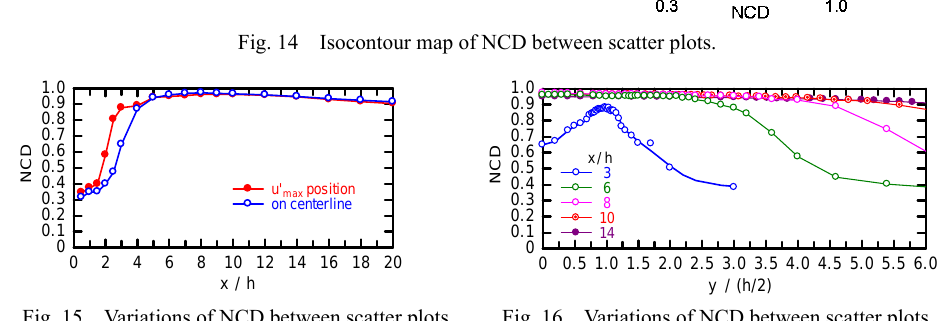
Fig. 15 Variations of NCD between scatter plots Fig. 16 Variations of NCD between scatter plots in streamwise direction. in y